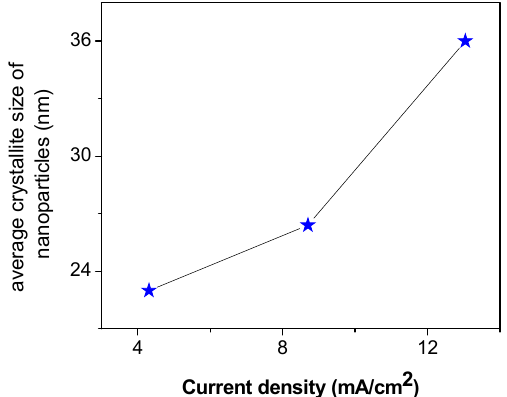
Fig. 7. The effect of current density on particle size while the synthesis process was carried out in the electrolytic cells without separators.